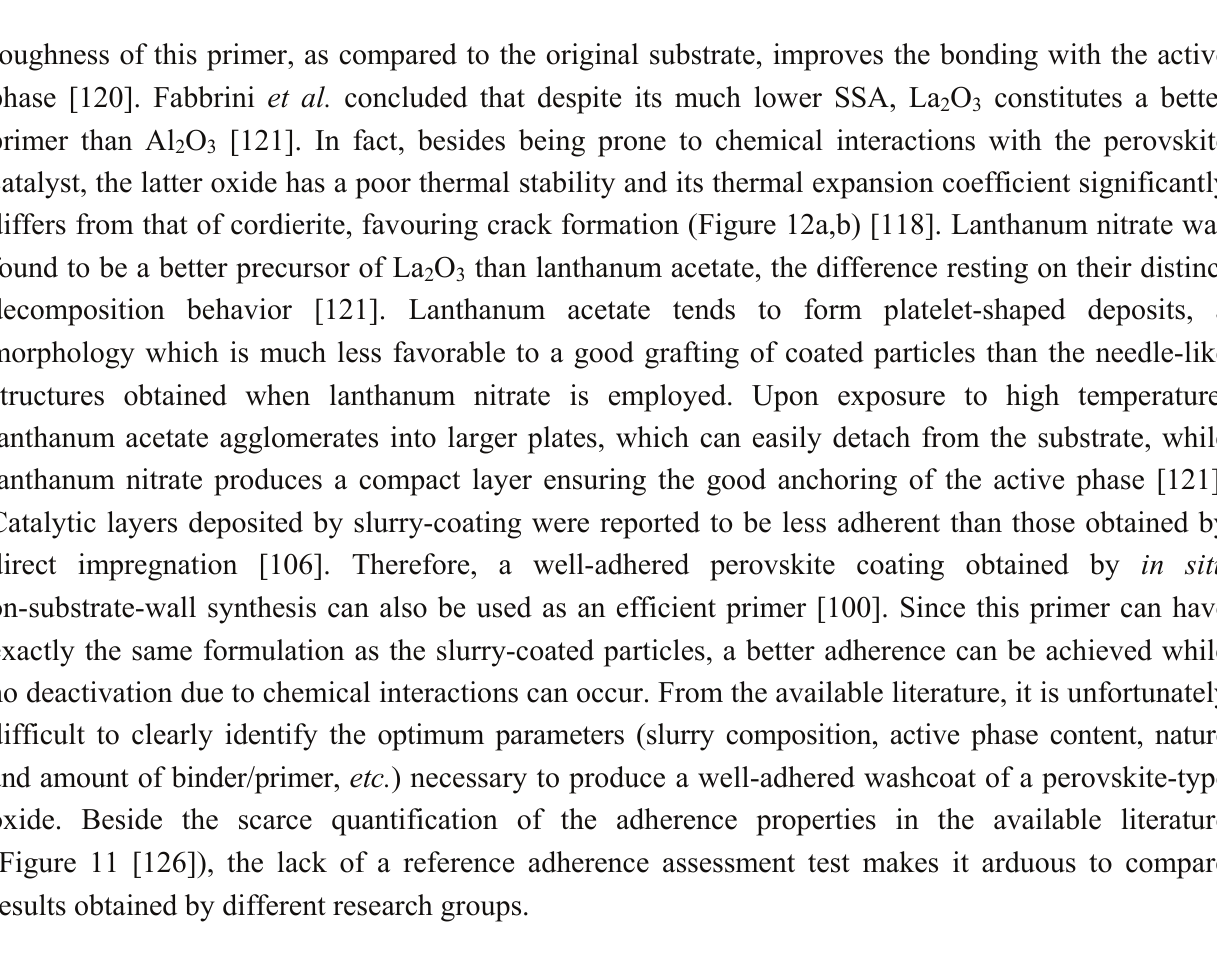
Ce CoO after accelerated ageing at 800 °C 0.9 0.1 3 O primer. Reproduced with permission 2 3